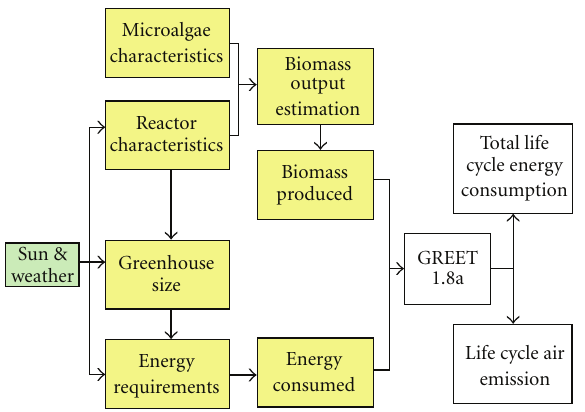
Figure 3: Overview of microalgae biomass LCA model. The yellow boxes represent the contributions of the work presented here. The soybean LCA results were taken almost entirely from GREET.